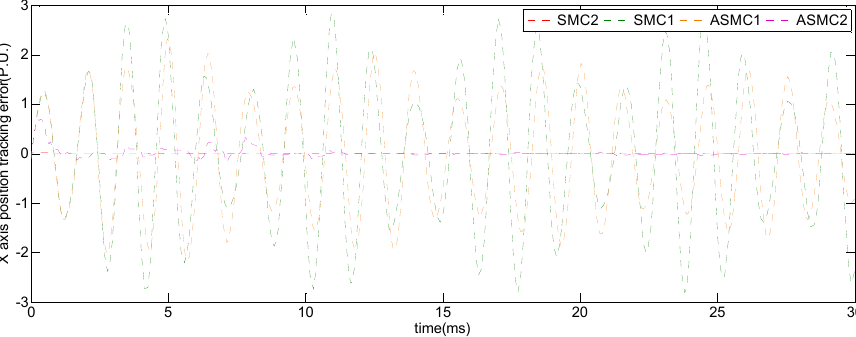
Figure 6. X axis tracking error comparisons of SMC2, SMC1, ASMC2, and ASMC1.